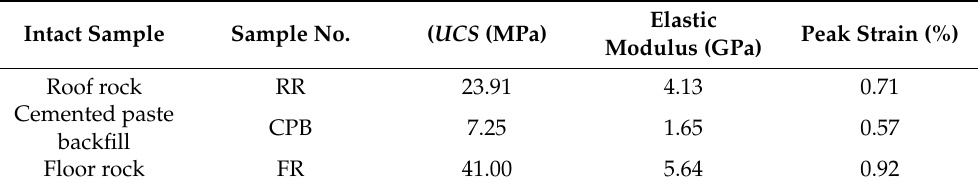
Table 2. Mechanical parameters and number of intact